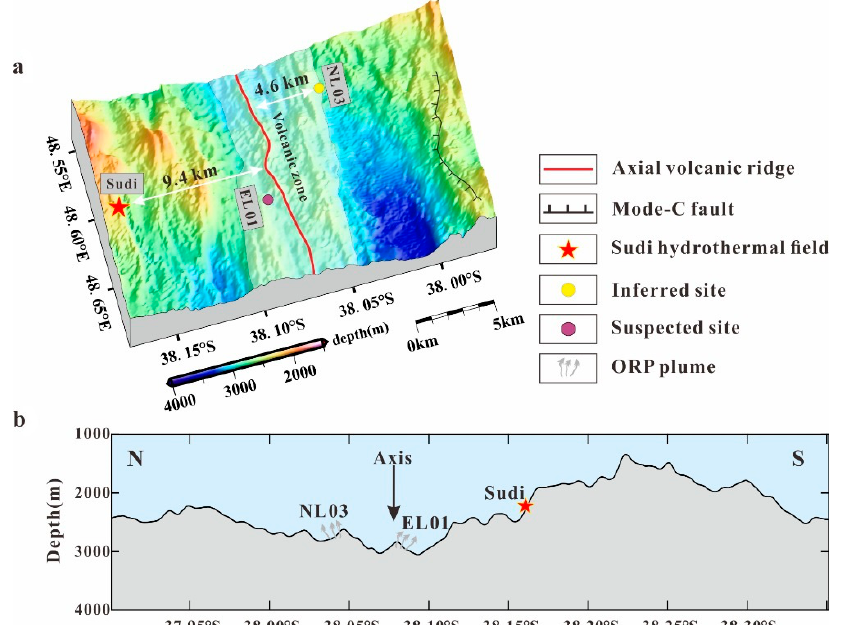
Figure 7. Distribution of hydrothermal anomaly sites for the western end of segment 30. ( a ) Distribution of hydrothermal anomaly sites in three-dimensional view. The transparent area indicates the axial volcanic zone. ( b ) Distribution of hydrothermal anomaly sites in schematic profile perpendicular to the ridge axis.